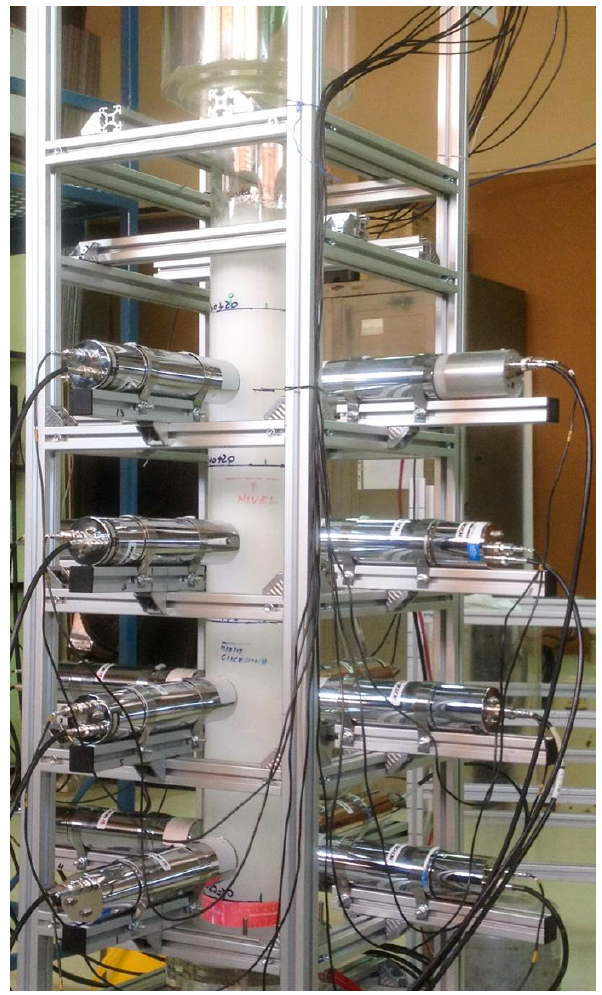
Figure 1 . Experimental setup: RPT detectors array. Figure 1. Experimental setup: RPT detectors Two modes of fluidization were considered in this work:  Liquid–solid fluidized bed (LSFB), where the solid phase motion is driven with the liquid flowing upward [38]. In this case, there is no gas flow. 